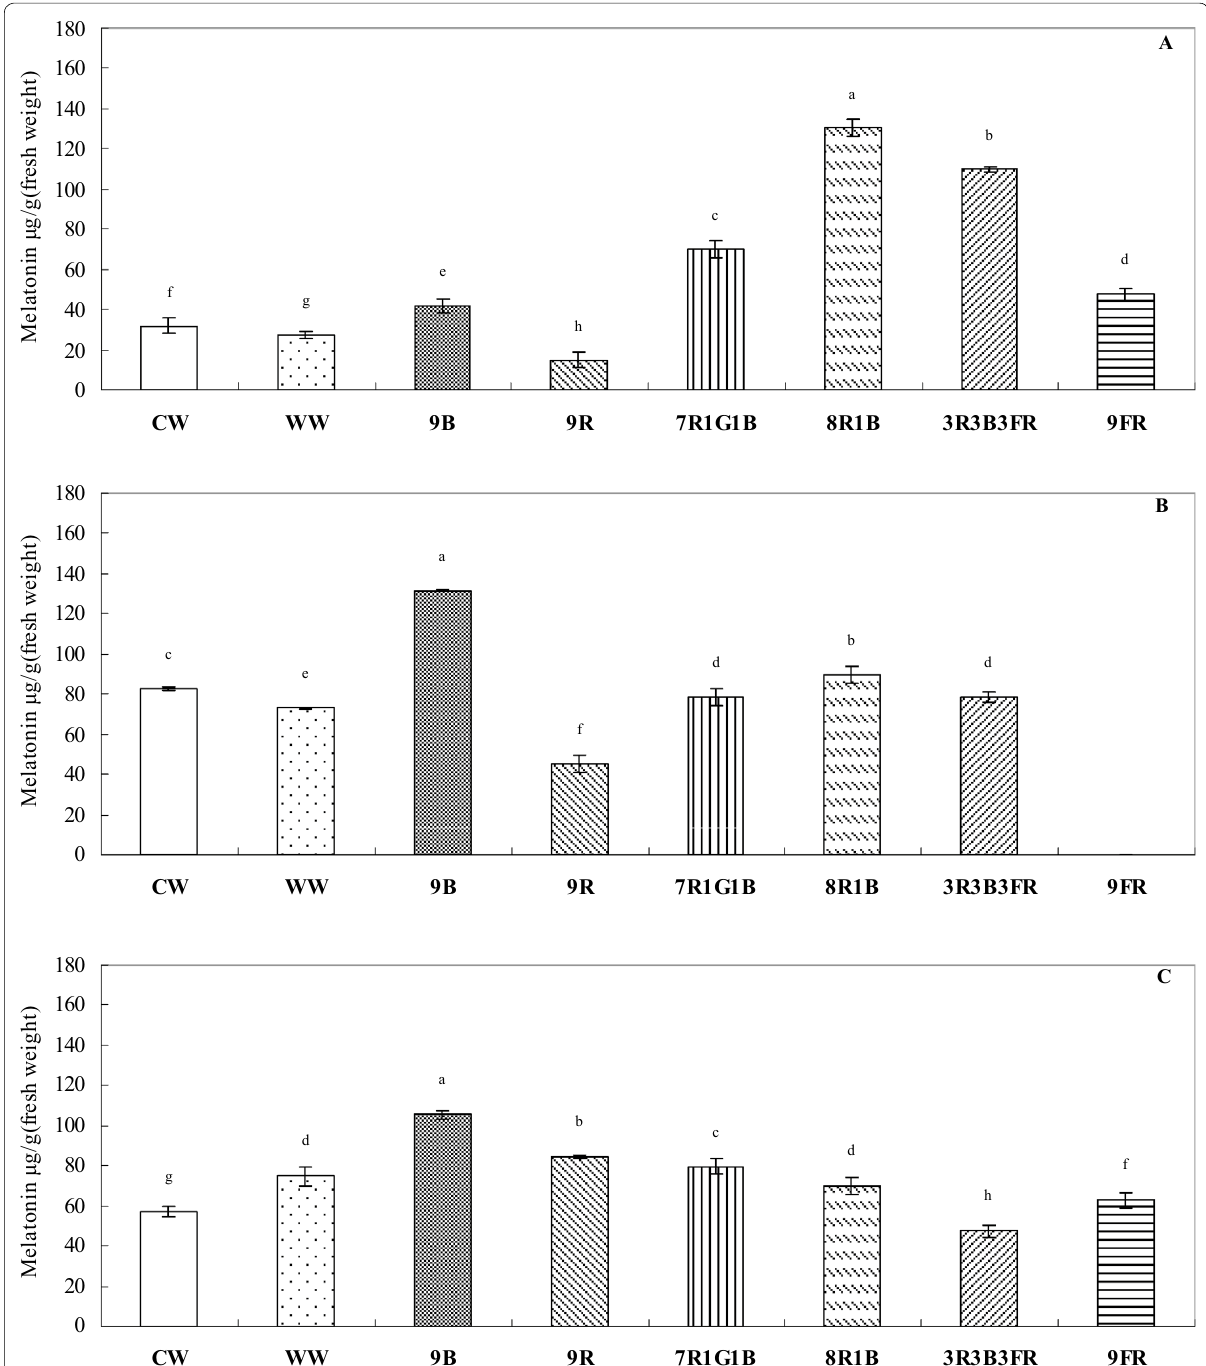
Fig. 5 Effects of light quality and intensity on melatonin concentration in H. perforatum L. a level F (approximately 90 µmol 5 (approximately 45 µmol m 2 /s photons), and c level 1 (approximately 9 µmol · (cool white light, 5000 K), WW (warm white light, 2700 K), 9B (450 nm), 9R (660 nm), 7R1G1B (R:G:B:IR